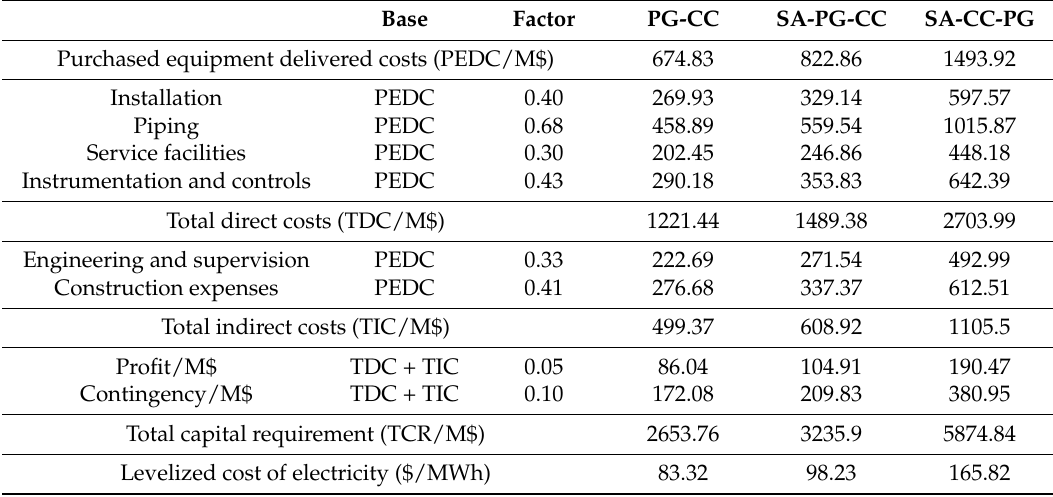
Table 10. Levelized cost of electricity analysis for coal-fired power-generation system with MEA-based CO 2 capture (PG-CC), solar-aided coal-fired power generation with CO 2 capture (SA-PG-CC) and solar-aided CO 2 capture coal-fired power generation (SA-CC-PG)